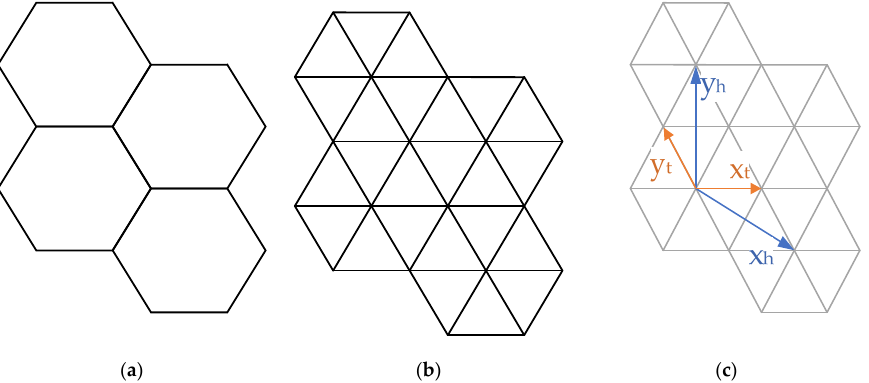
Figure 18. Hexagonal grid to triangular grid. ( a ) Hexagonal grid cells; ( b ) Triangles obtained by decomposing hexagons; ( c ) Coordinate systems for triangular and hexagonal grids, x t and y t are triangular grid coordinate systems, x h and y h are hexagonal coordinate systems.